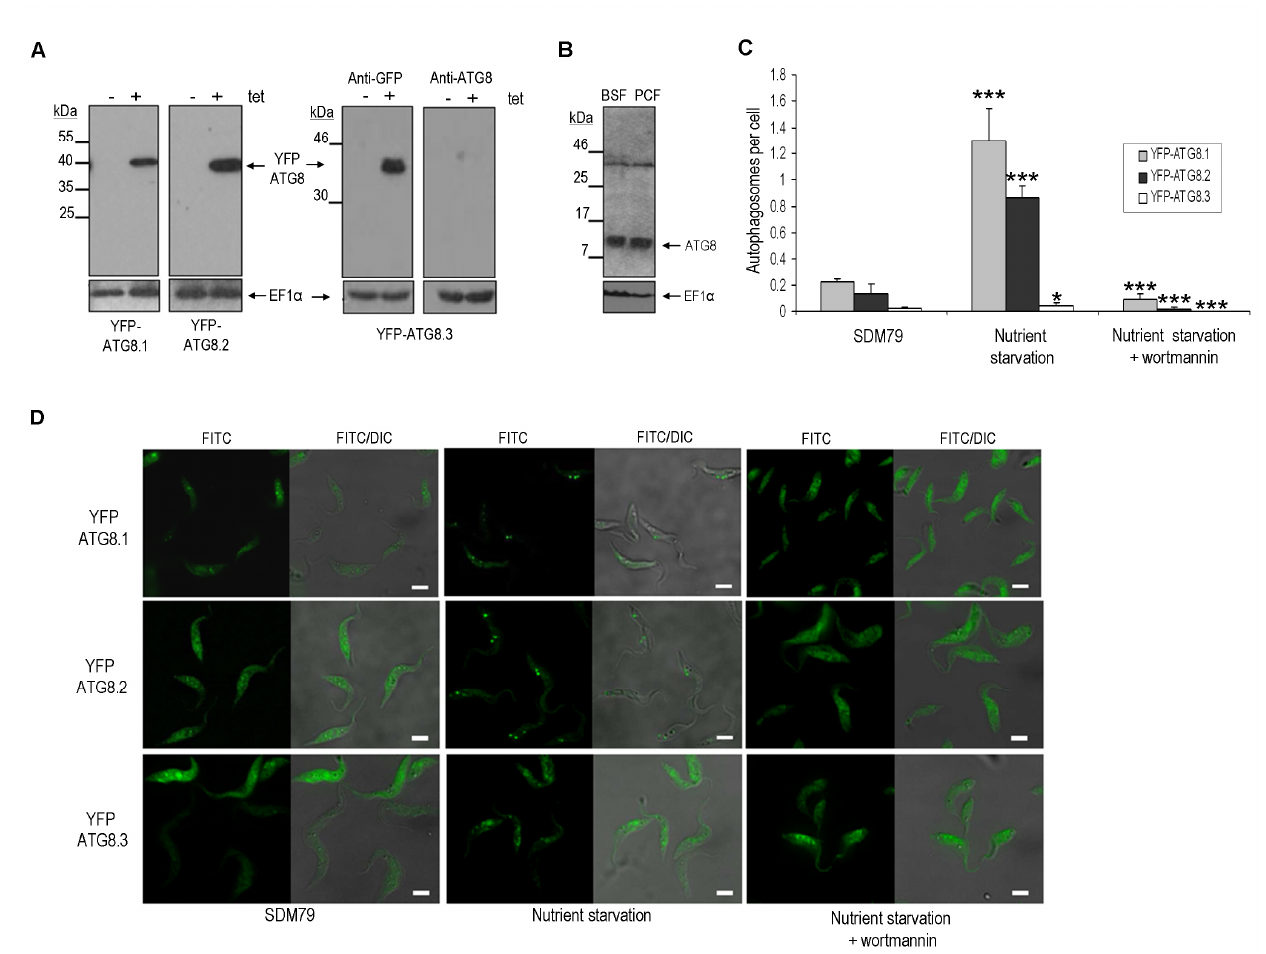
FIGURE 1: Conditional expression of YFP-ATG8 proteins in procyclic form T. brucei . (A) Expression of individual YFP-ATG8 fusion proteins was induced by growing cells for 24 h in media containing tetracycline (tet). 1 x 10 6 cells were loaded per lane and immuno-blotted with anti- ATG8.1 or anti-GFP antibody. Anti-EF1α was used to demonstrate equal loading. (B) Endogenous ATG8 expression. 5 x10 6 wild type BSF and PCF cells loaded per lane, were probed with anti-ATG8.1. Anti-EF1α was used to demonstrate equal loading. (C) Fluorescent microscopy was used to monitor the presence of autophagosomes in PCF cells conditionally expressing YFP fusion proteins following growth in SDM79 media, starvation in PBS for 2.5 h or 2.5 h nutrient starvation in PBS supplemented with 10 µM wortmannin. The mean number of autophagosomes per cell was determined by counting >200 cells with data displayed as a mean of three replicate experiments from three independent clones. Error bars represent standard deviation and asterisks indicate where data differed significantly from the mean of the non-starved controls *p<0.05, ***p<0.001. (D) Representative images of cells assessed as for C. Left hand images FITC filter set, right hand images DIC FITC merge. Scale bar 5